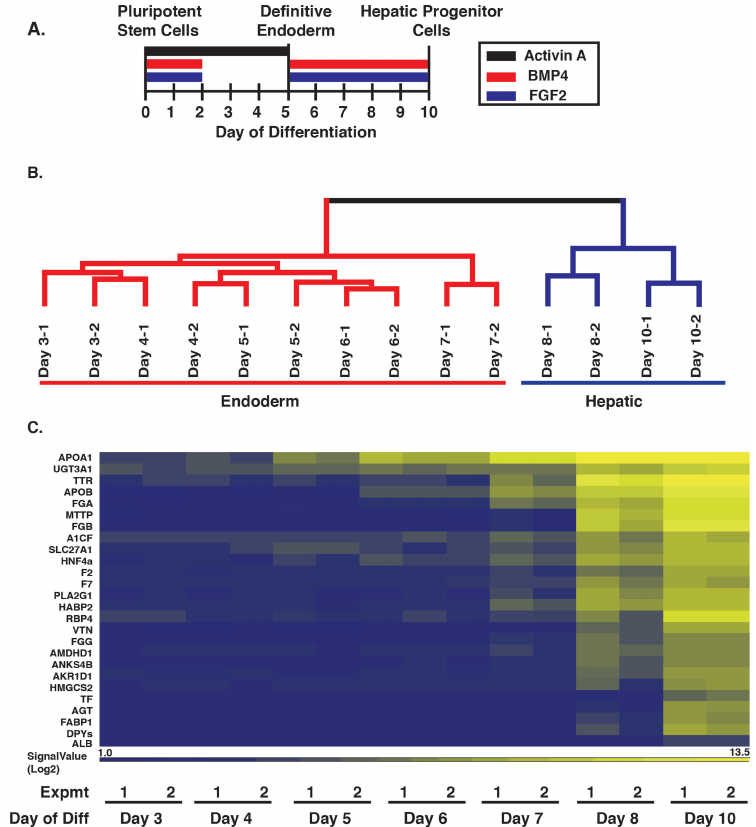
Figure 1. Transition of induced pluripotent stem cells (iPSC)-derived endoderm to a hepatic fate occurs between days seven and eight of differentiation. ( A ) Diagrammatic overview of the procedure used to generate hepatic progenitor cells from iPSCs that has been described in detail elsewhere [30,45]; ( B ) Dendrogram showing unsupervised hierarchical cluster analyses of transcriptional profiles generated using oligonucleotide arrays that were performed on duplicate differentiations collected daily between days three (endoderm) and day ten (hepatic progenitor cells). Note that cells with endoderm character cluster between days three and seven (red) and those with hepatic character cluster between days eight and ten (blue); ( C ) heat map showing the changes in levels of characteristic hepatic mRNAs during the differentiation time